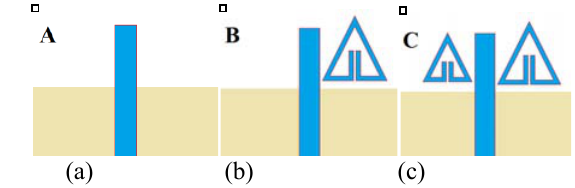
Fig.5 (a) Monopole antenna, (b) A dual-band monopole antenna with single-cell MTM loading on the right, (c) Tri- band monopole antenna load with two unit